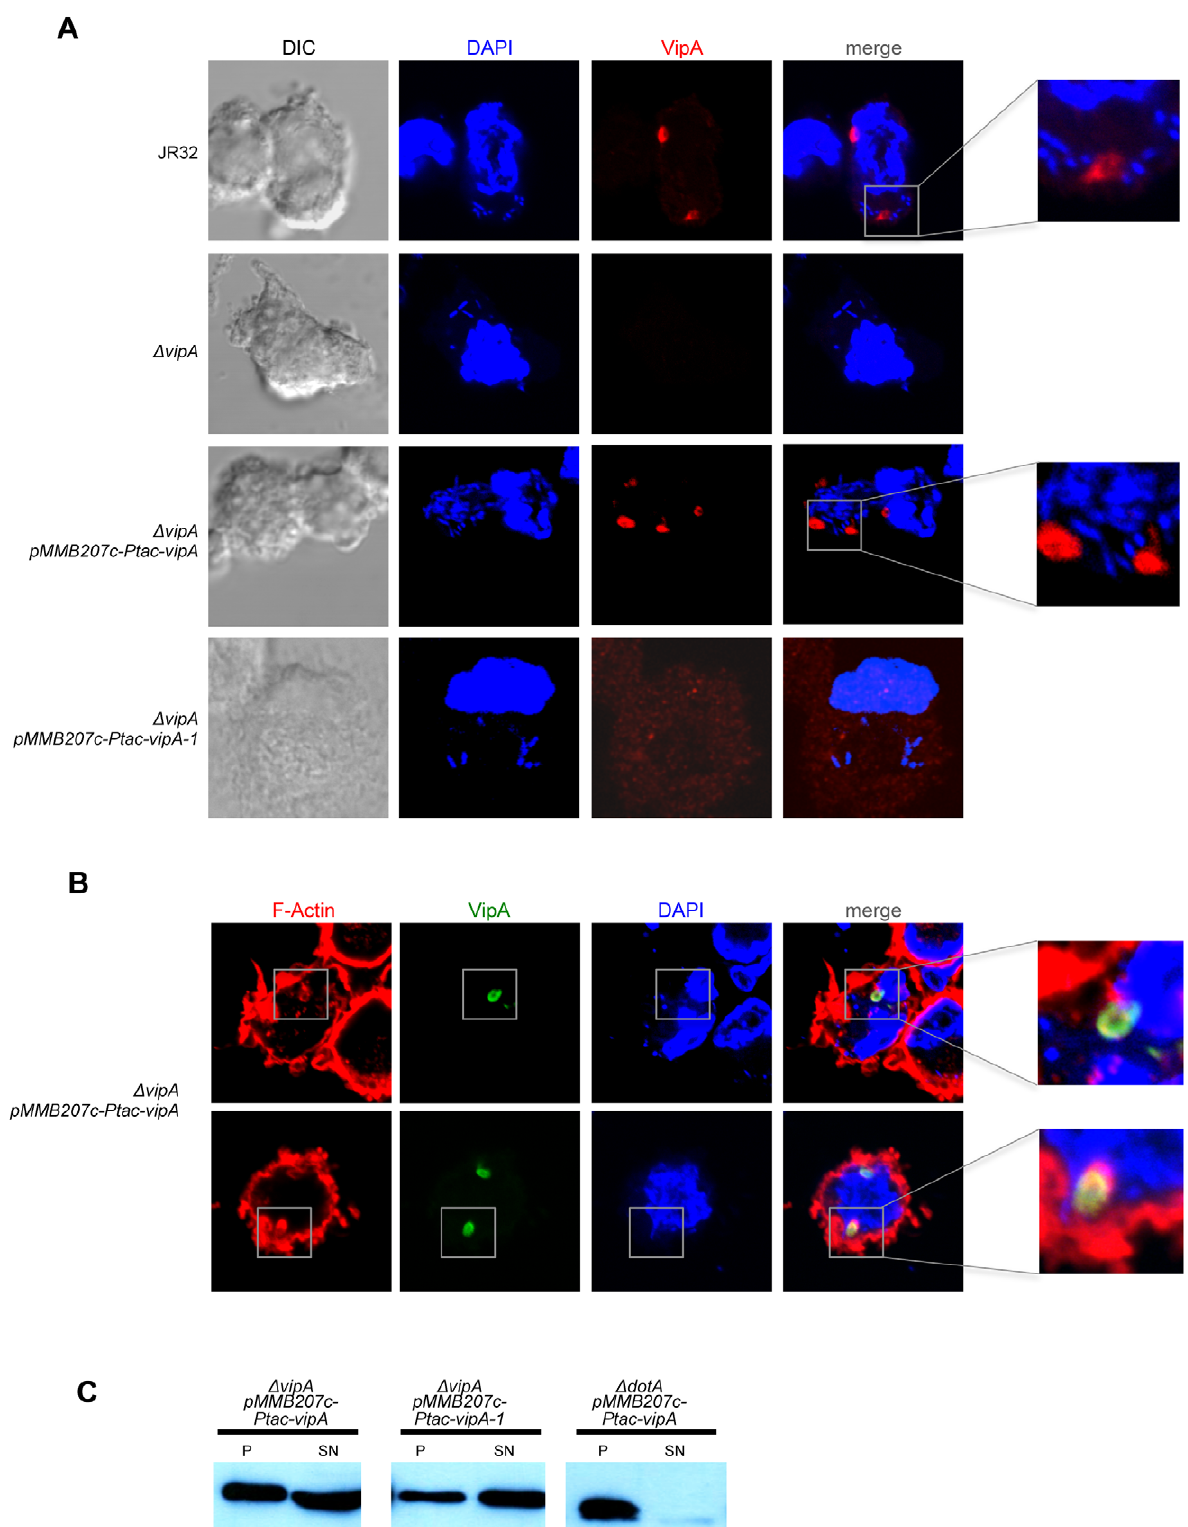
Figure 6. Localization of translocated VipA and VipA-1 during infection of THP-1 macrophages. THP-1 macrophages were infected with L. pneumophila strains (JR32, D vipA , D vipA pMMB207c-Ptac-vipA or D vipA pMMB207c-Ptac-vipA-1 ) with an MOI=50 for 8 hours. Immunofluorescence was carried out as described (Materials and Methods). DNA was stained with DAPI and VipA with a purified polyclonal anti-VipA antibody. A. and F-actin was stained with Rhodamine-phalloidin. B. Representative confocal microscopy images are shown. C. Immunoblot of samples containing lysates of THP-1 macrophages infected for 3 hr with the indicated L. pneumophila strains at an MOI=50 (see Material and Methods). P, lysate pellet; SN, lysate supernatant. doi:10.1371/journal.ppat.1002546.g006 PLoS Pathogens |